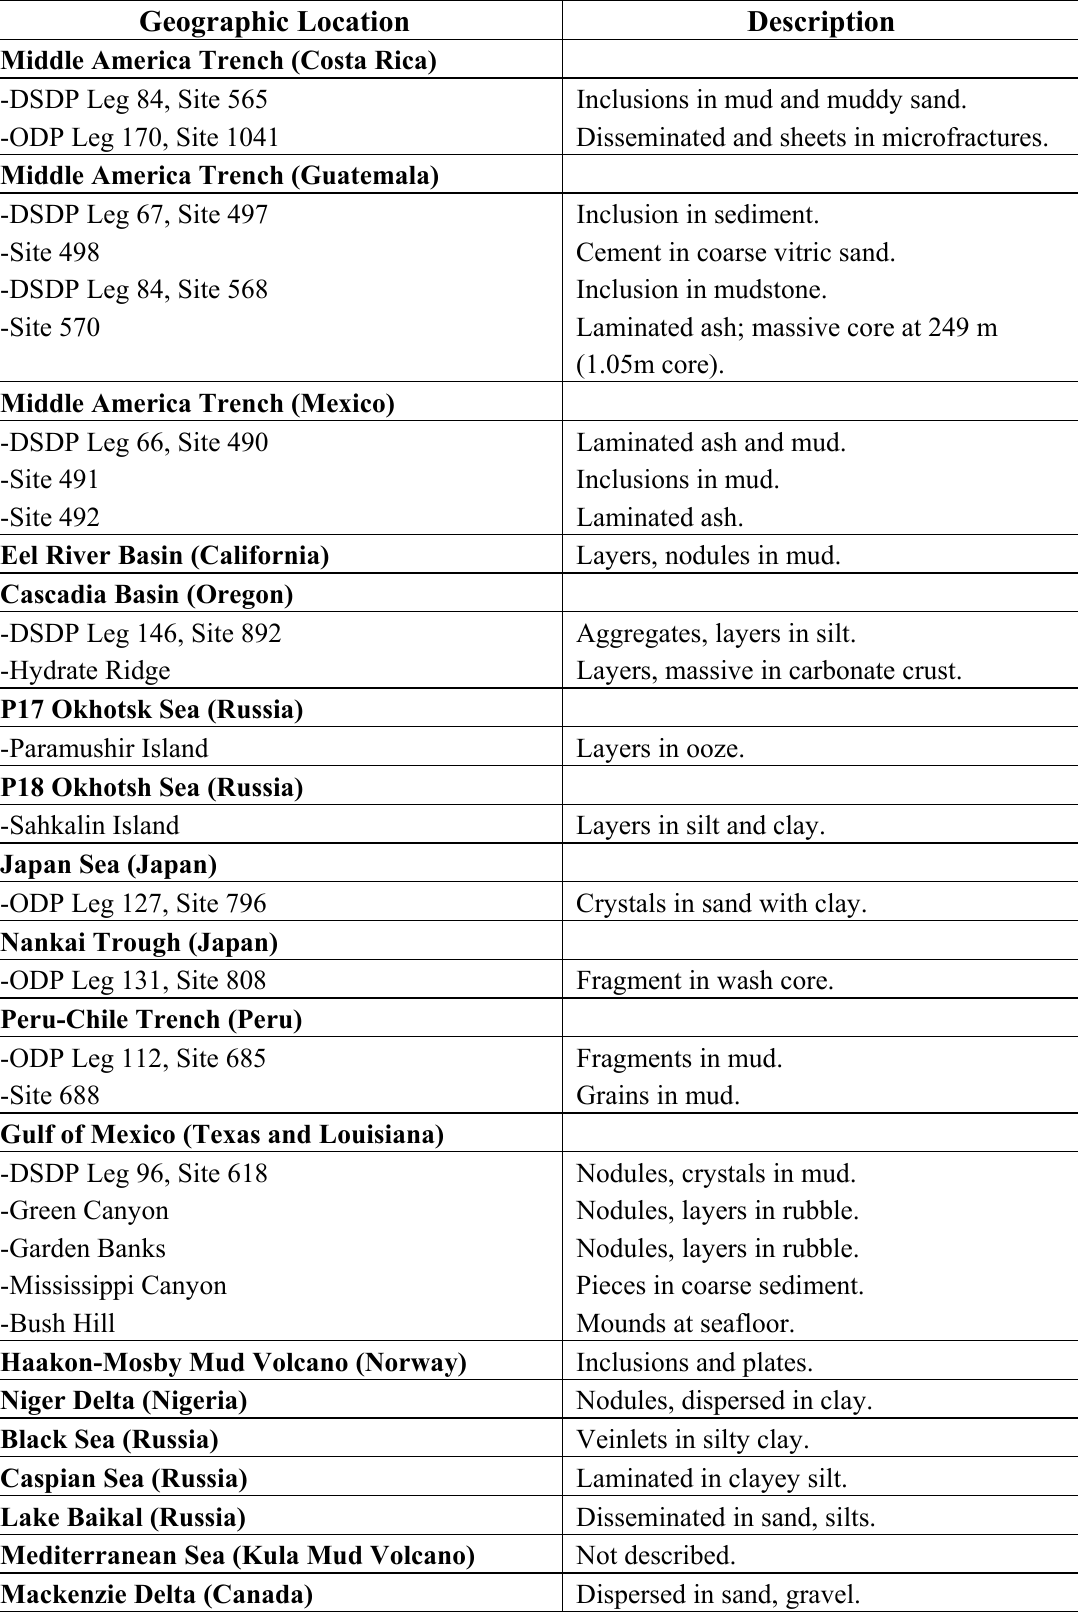
Table 1. Various Locations of Hydrate Occurrence and Sample Descriptions